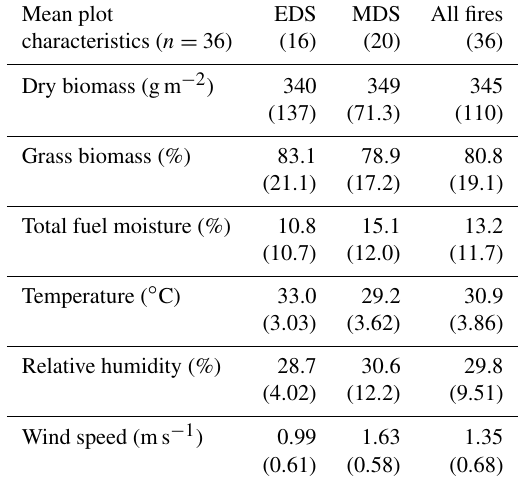
Table 1. Mean plot characteristics by study period ( n and standard deviations in parentheses) (2014–2016,